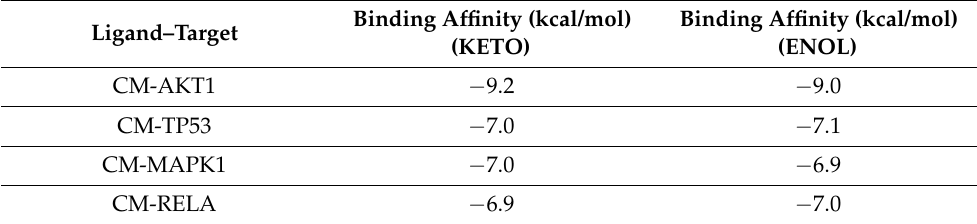
Table 2. The calculated binding affinity of ligand–target.